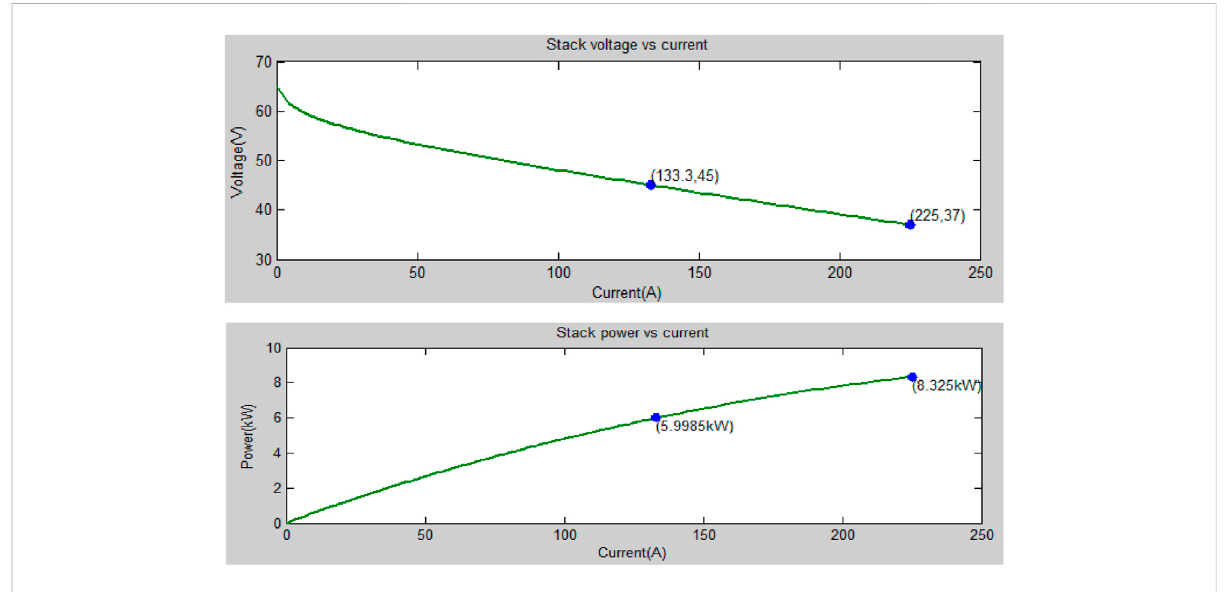
FIGURE 9 Characteristics of a 6-kW PEM fuel